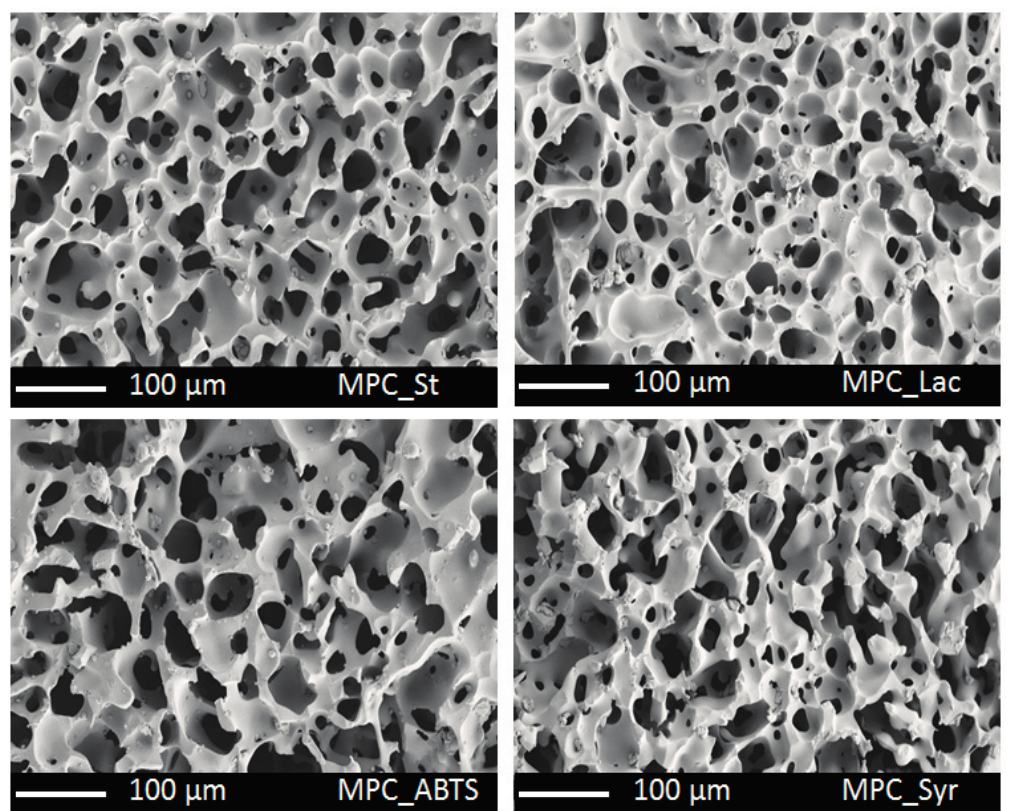
Figure 4. SEM images of the morphology of the standard cryogel, and of the cryogels with immobilized laccase, ABTS,